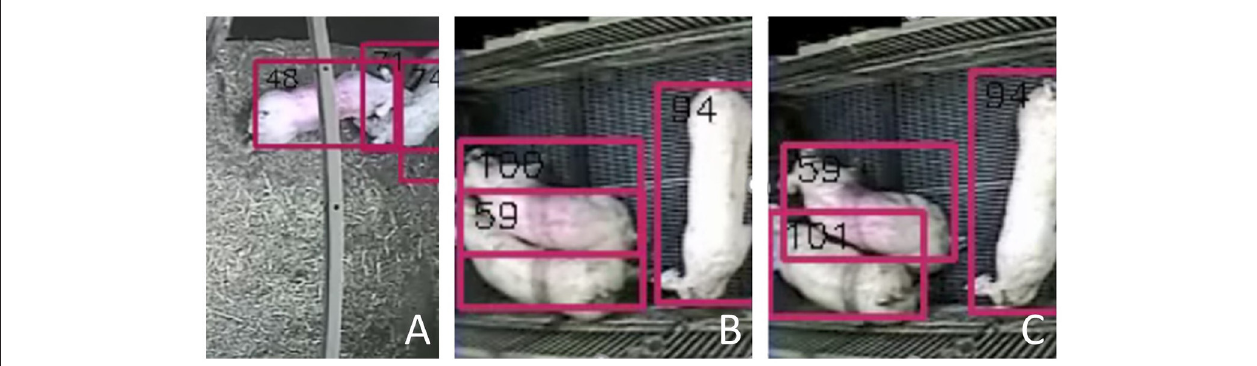
FIGURE 3 | Examples of FP tracks and ID switches: (A) An example of a false positive (FP) track, where two pigs are visible, but three bounding boxes are identified. The bounding box most right (nr. 74) is labeled as a FP track since it could not be assigned to a pig; (B) The moment just before the ID switch of pig nr. 59; (C) Just after the ID switch, where bounding box nr. 59 has moved up to another pig compared to (B) . The original pig nr. 59 received a new ID.